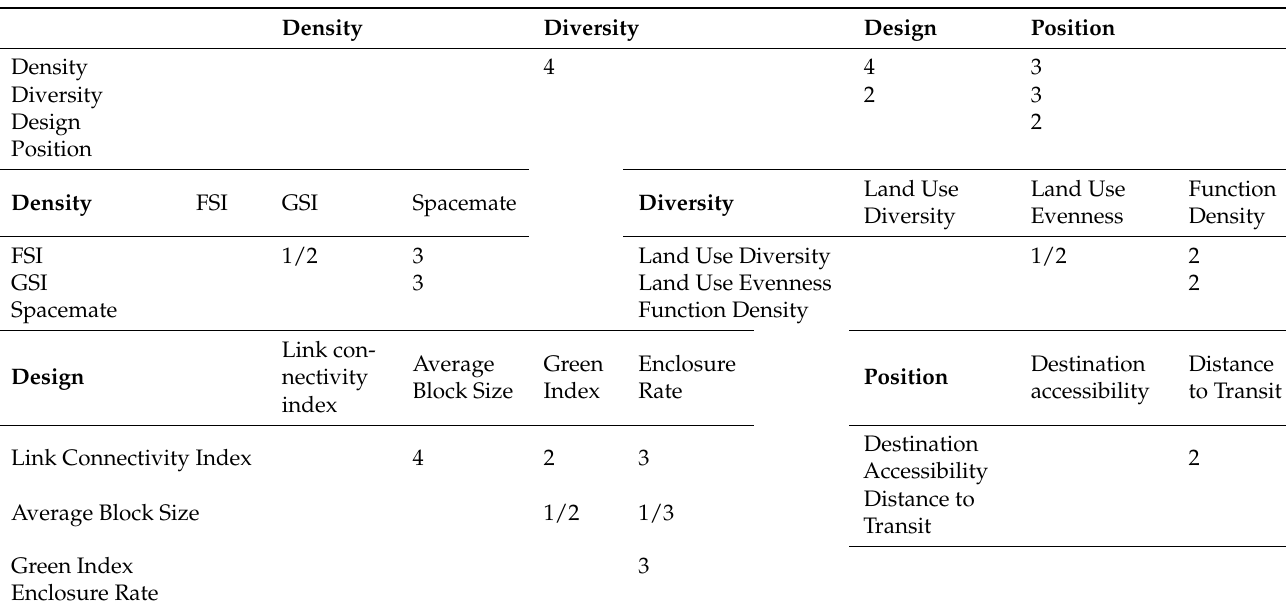
Table A3. Expert